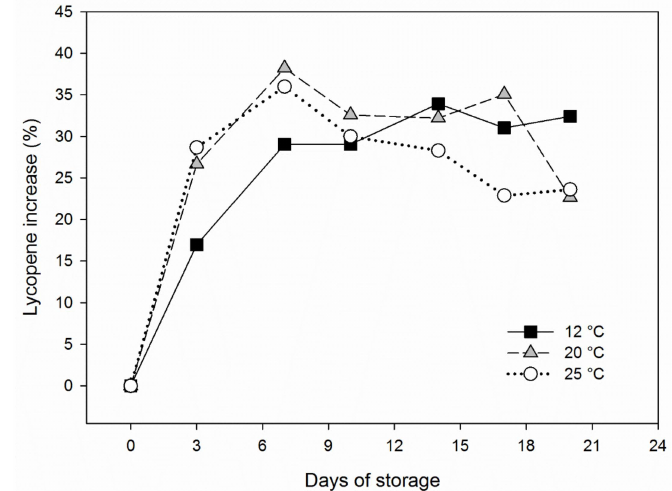
Figure 3. Lycopene increase (%) in pink harvested processing tomatoes, cv. Calista, during storage in the dark at 3 di ff erent temperatures (12, 20, and 25 ◦ C) and 80% relative humidity. The initial level of lycopene was about 6.5 mg / 100g fresh weight (FW). Rearranged from data previously published in Sikorska-Zimny et al., 2019 [66], with